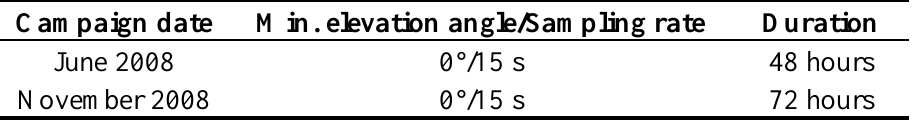
Table 2. GNSS campaign